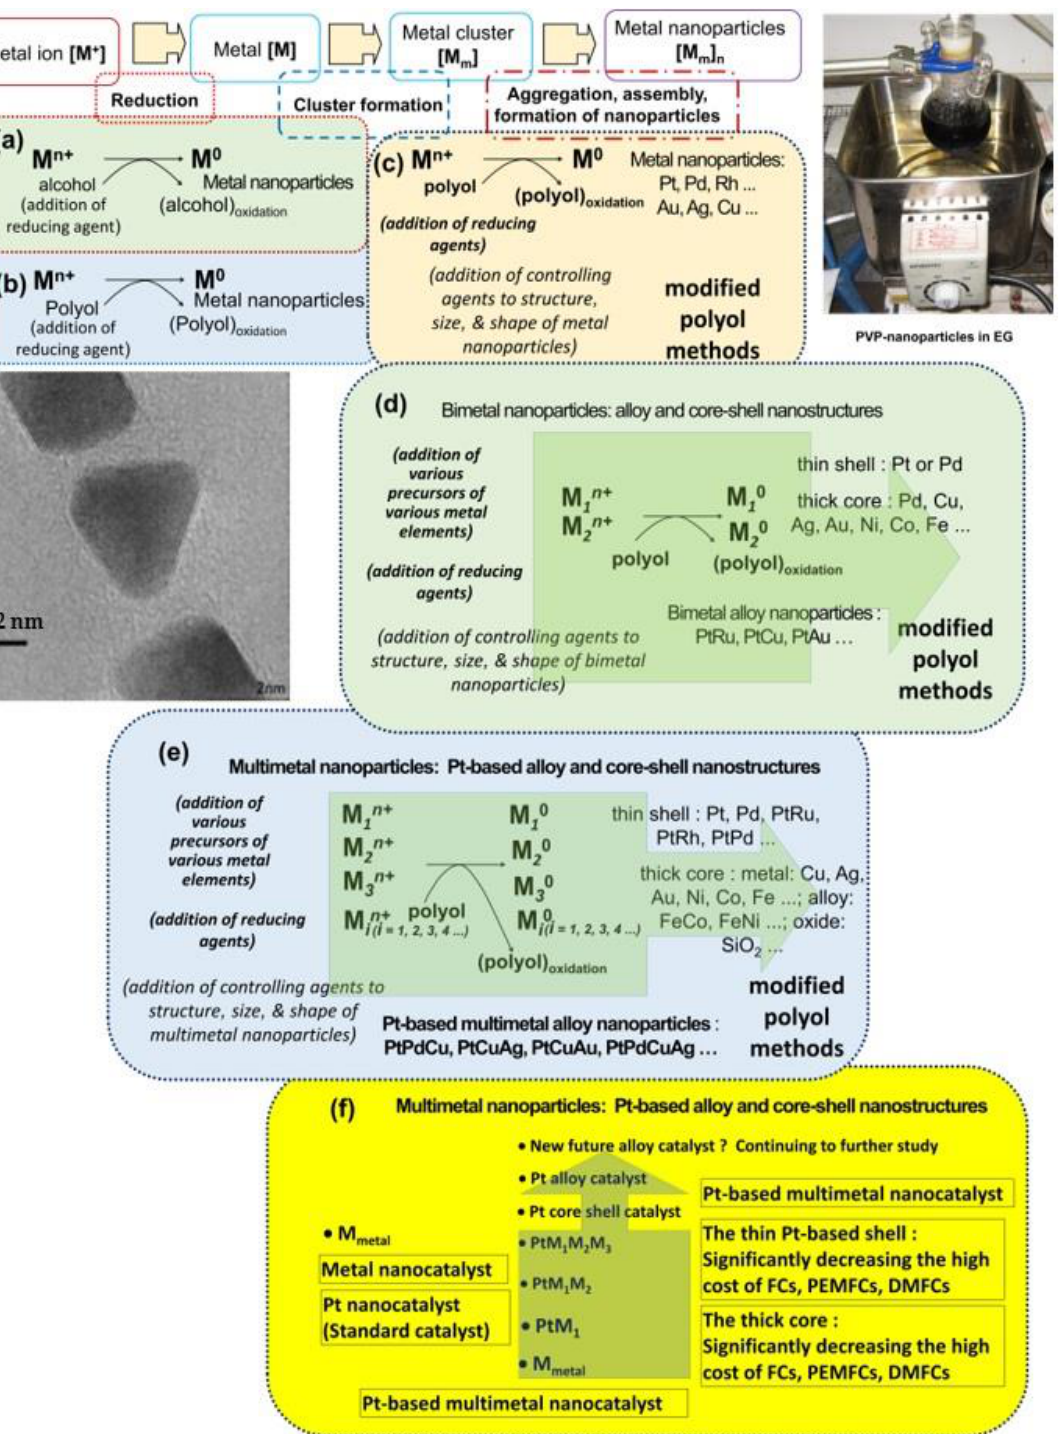
Figure 3. To prepare new multimetal electrocatalysts successfully, we must successfully synthesize single-metal catalysts in a controlled polyol process. The formation and mechanism of crystal struc- tures of metal, bimetal, multimetal alloy and core-shell nanoparticles must be intensively discussed in the detail. The stepwise strategies of modified polyol methods are used in order to fabricate Pt-based multimetal alloy and core-shell nanostructures with the thin Pt shells. ( a – f ) Synthesis of metal, bimetal, and multimetal nanoparticles in the special flasks of alcohols, polyols, i.e., EG or PEG by modified polyol methods. High resolution TEM image of Pt nanoparticles from [26].